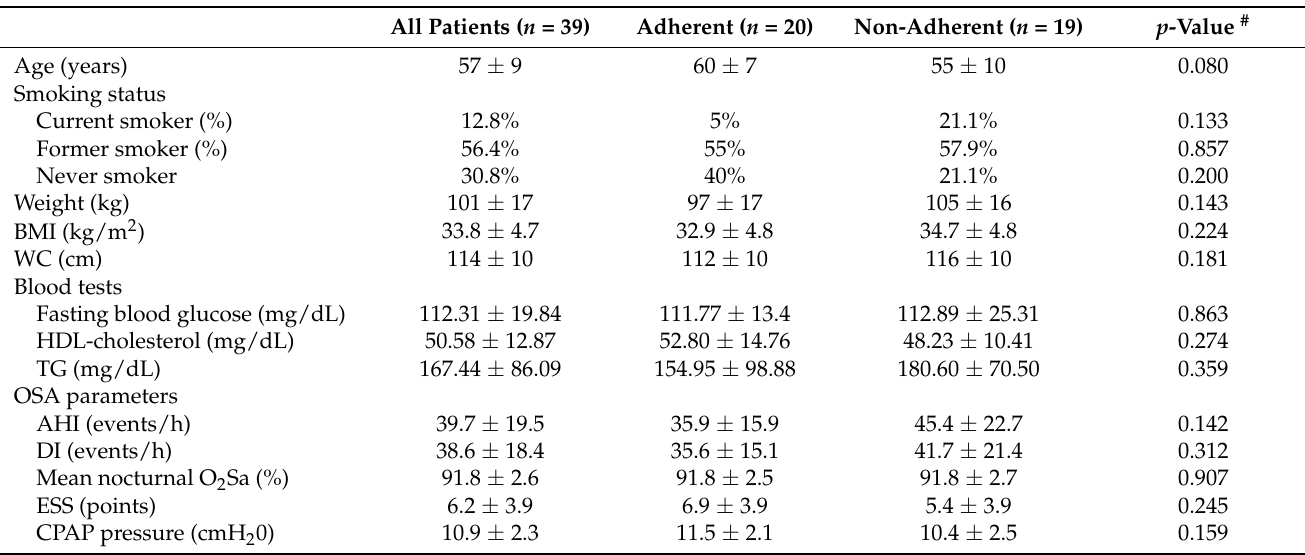
Table 1. Baseline demographic, anthropometric, biochemical, and cardiorespiratory polygraphy characteristics in the study population.